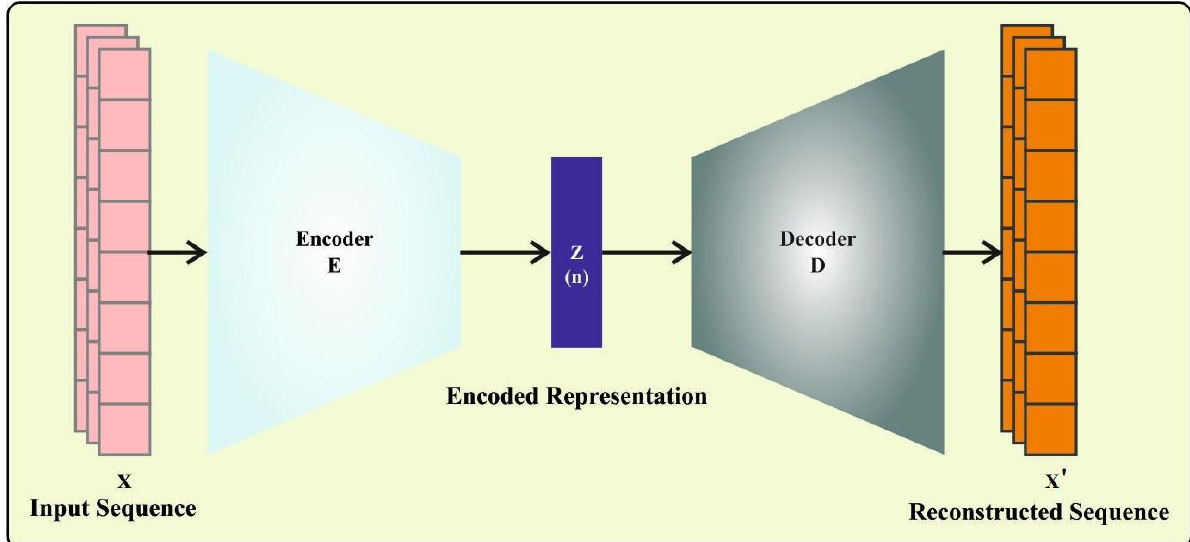
Figure 2. The architecture of the LSTM-AE model.